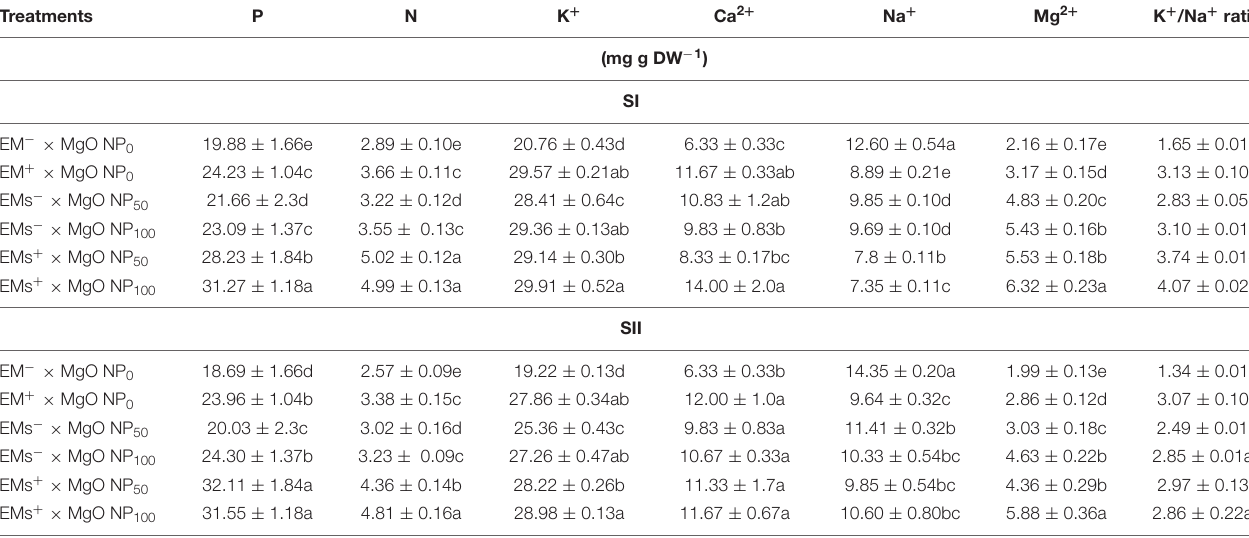
TABLE 5 | Effect of foliar application with magnesium oxide (MgO) nanoparticles (MgO-NP) and effective microorganisms (EMs) on the concentrations of leaf photosynthetic pigments and plant water status of sweet potato ( Ipomoea batatas L.) grown in salt affected soil in 2020 (SI) and 2021 (SII) seasons. Treatments